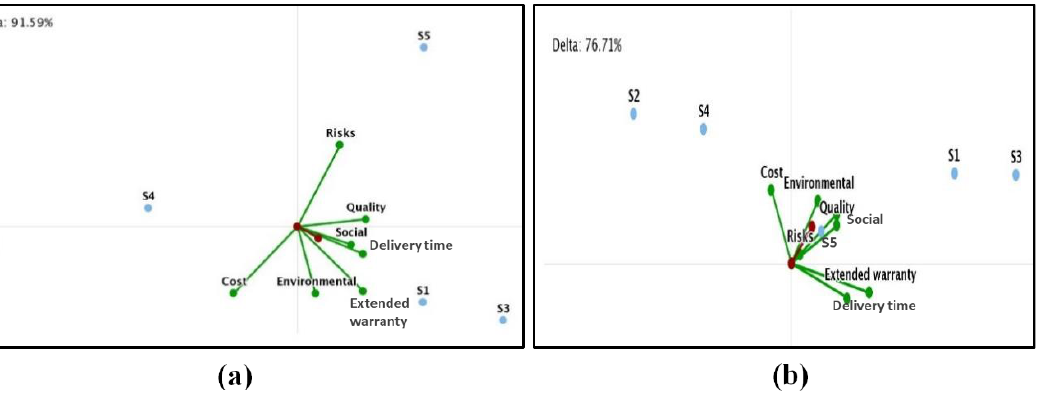
Figure 6. GAIA plane for economic subcriteria and criteria dimensions. ( a ) PROMETHEE. ( b ) MAUT.